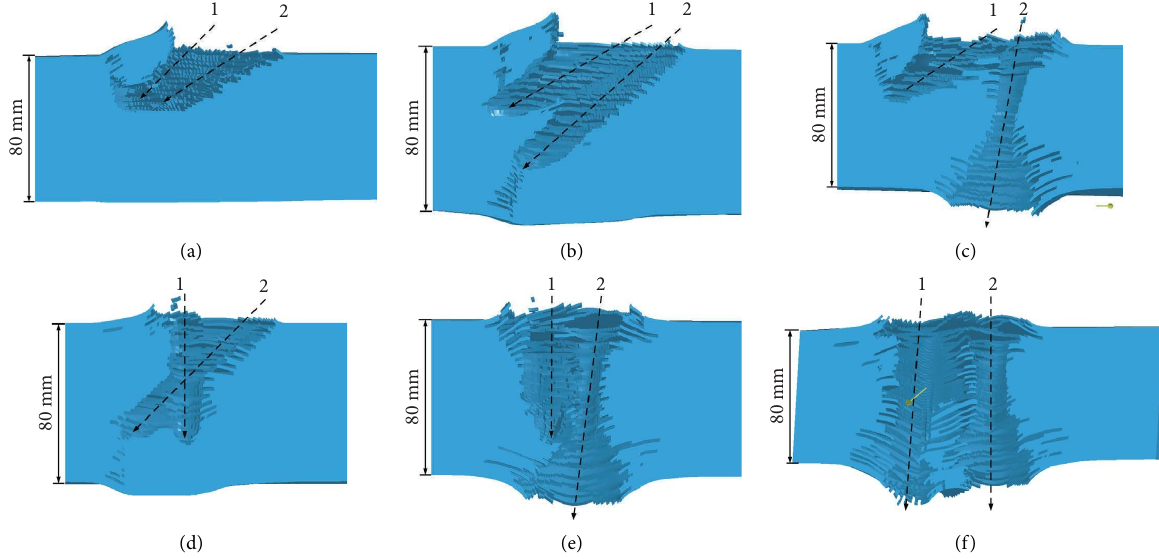
Figure 17: Typical six types of abnormal surface damage forms. (a) Front pit-front pit (group 8). (b) Front pit-tunnel (group 6). (c) Front pit-penetration (group 3). (d) Tunnel-tunnel (group 15). (e) Tunnel-penetration (group 7). (f) Penetration-penetration (group